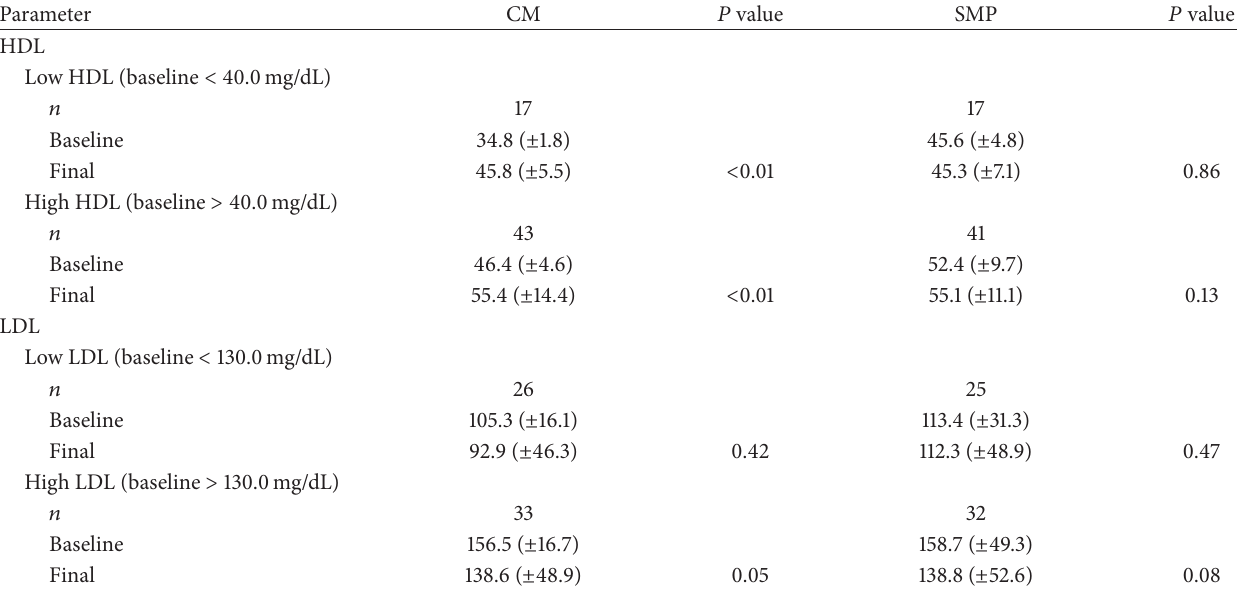
Table 3: Effects of CMP and SMP supplementation on lipid